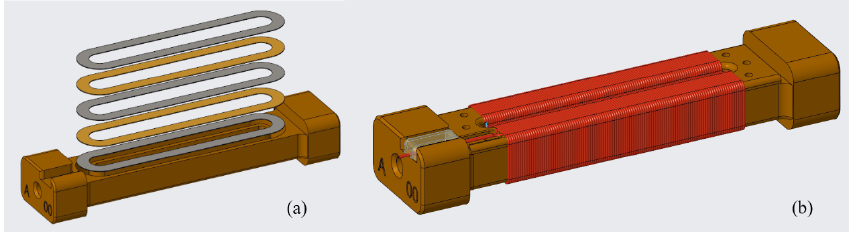
Figure 2. (a) Layers of foil loops are stacked within a Torlon bobbin with a layer of Kapton placed in between permalloy layers. (b) The bobbin serves as a frame for the drive coils which are wound on the two long racetrack supports.